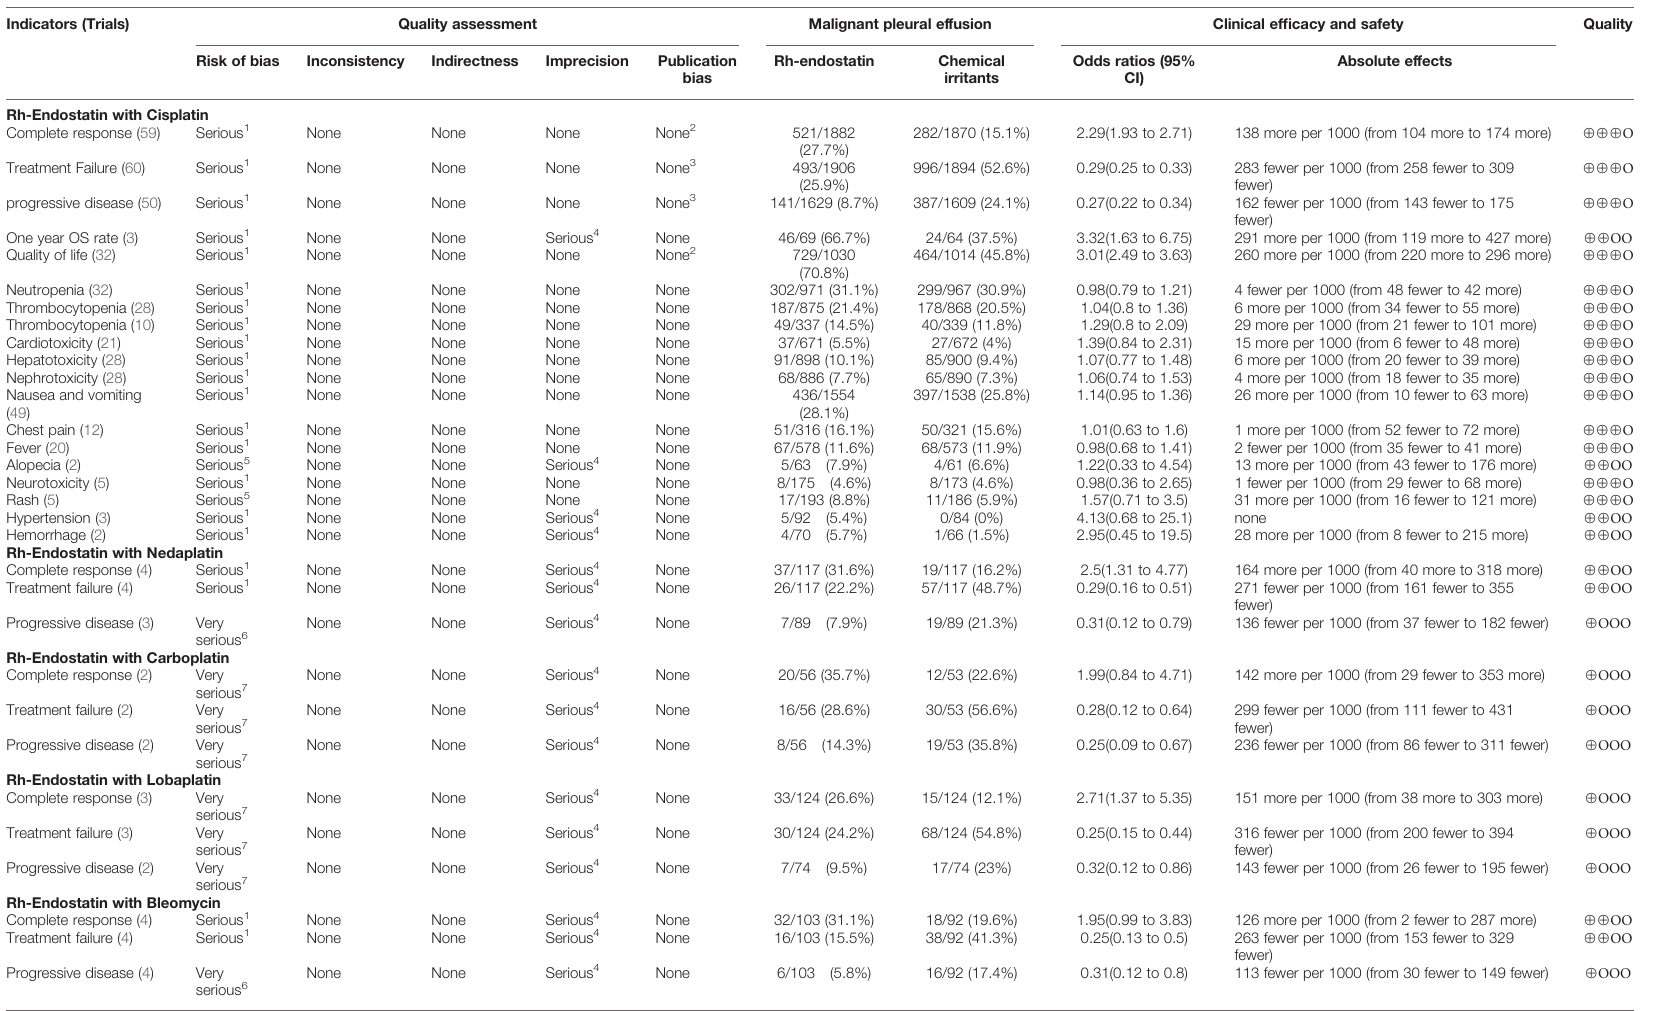
TABLE 5 | GRADE evidence pro fi